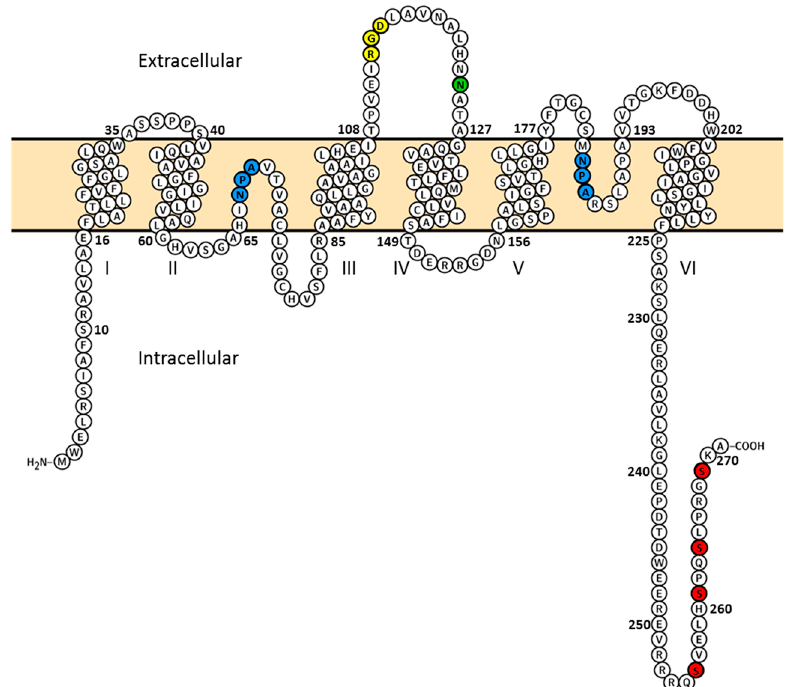
Figure 1. Membrane topology of rat aquaporin-2 (AQP2). Topology of rat AQP2 (Uniprot entry P34080) visualized with Protter [13]. AQP2 is an integral membrane protein with six transmembrane helices (I to VI). Two NPA motifs (blue residues) are found between the transmembrane helices II to III and V